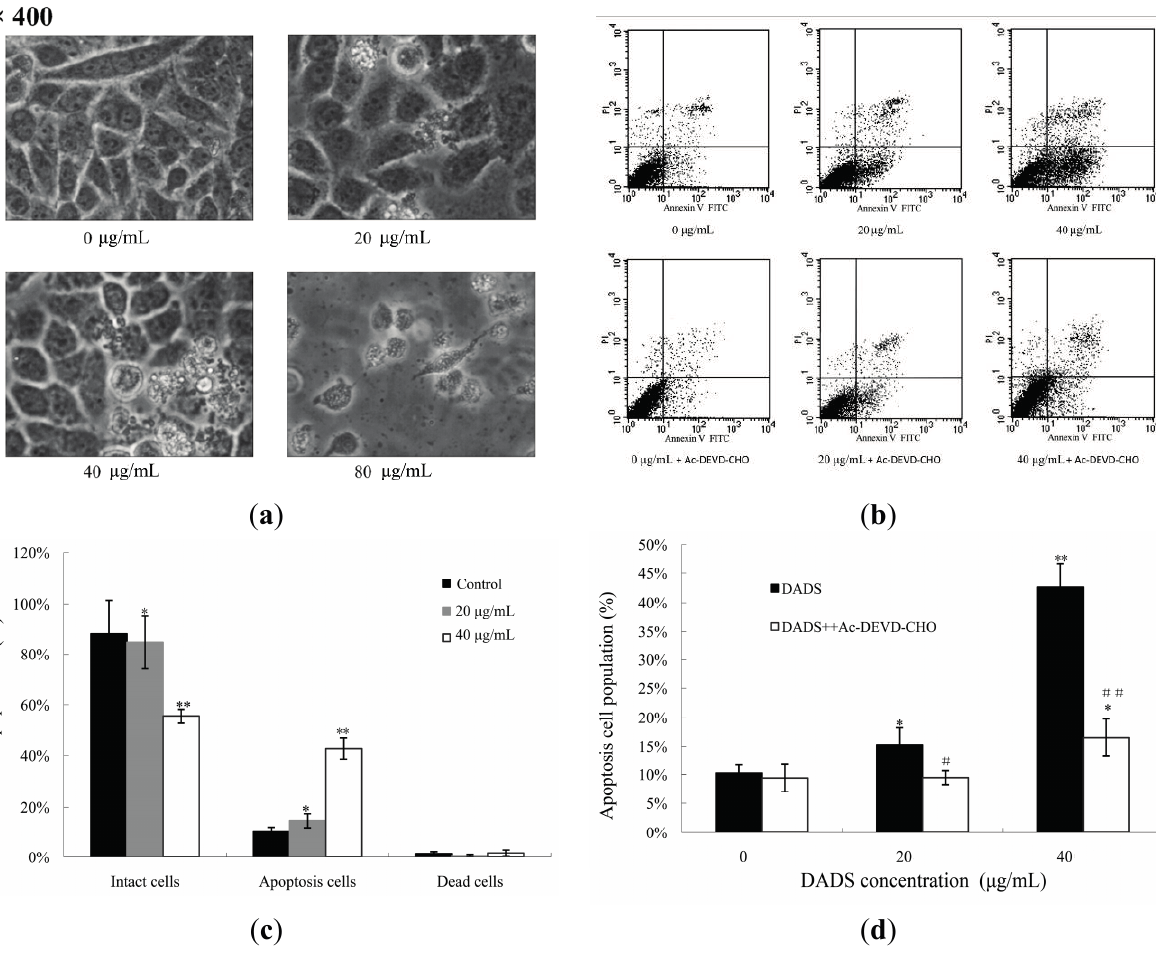
Figure 3. Apoptotic effects of DADS on ECA109 cells. ( a ) Morphology of ECA109 cells treated with different concentrations of DADS for 24 h and examined under phase contrast microscopy (×400); ( b ) DADS (0, 20 and 40 μ g/mL) induced dose-dependent apoptosis in ECA109 cells. Ac-DEVD-CHO inhibited the apoptosis induced by DADS. Apoptosis was assessed using Annexin V-FITC/propidium iodide (PI) double staining; ( c ) Statistical analysis of the apoptosis rate of DADS; ( d ) Effects of Ac-DEVD-CHO against the apoptosis induced by DADS. Data are expressed as the mean ± SD from three independent experiments (* p < 0.05, ** p < 0.01 compared with the control group, # p < 0.05, ## p < 0.01 DADS + Ac-DEVD-CHO compared with